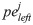
Identification of insertions or deletions.A discordant read rj is mapped on the reference with two mapping locis, peleftj and perightj. The spanning region of rj is from (peleftj+l) to perightj. And the potential breakpoint pair of SVi is initialized from peleftj+l to perightj.